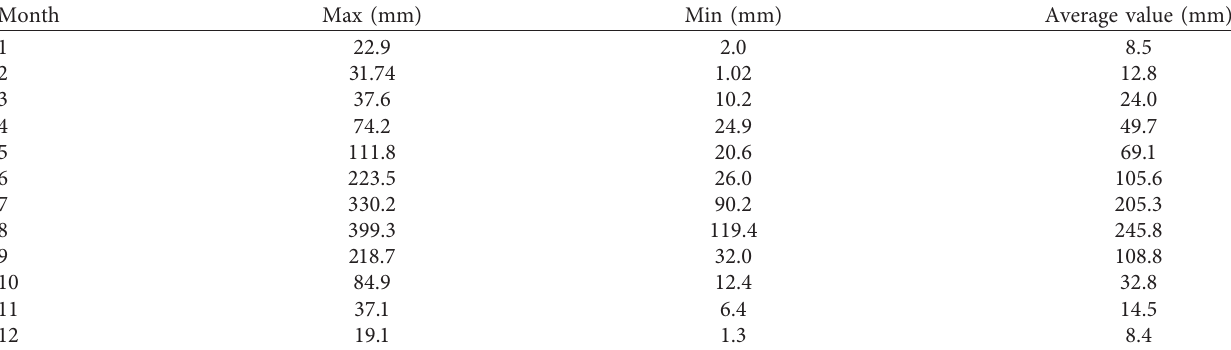
Table 3: Distribution characteristics of average rainfall in Chengdu from 1990 to 2019.